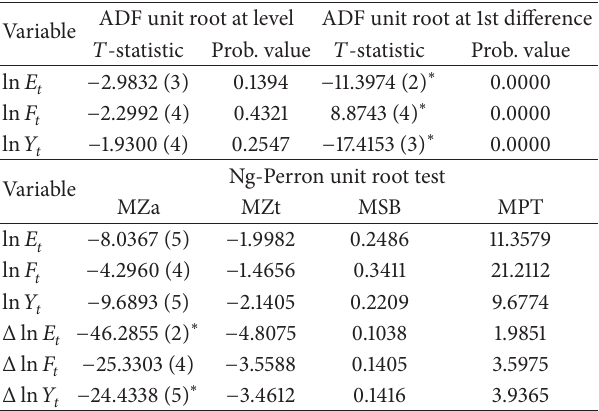
Table 2: Unit root